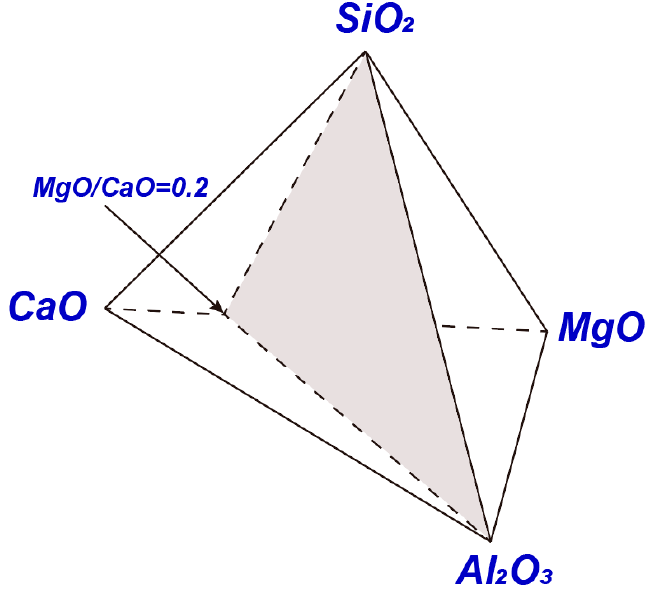
Figure 16. Representation of the pseudo-ternary phase diagrams (CaO + MgO)-Al 2 O 3 + SiO 2 at a constant MgO/CaO ratio of 0.2 [23]. An experimentally determined pseudo-ternary phase diagram (CaO + MgO)-Al 2 O 3 - SiO 2 with a constant MgO/CaO ratio of 0.2 is shown in Figure 17. A typical BF slag com- position and four special points are also shown in the figure. When the compositions of the iron ores and coke/coal vary, the Al 2 O 3 and SiO 2 contents in the BF slag will change accordingly. Based on Figure 17, the effects of Al 2 O 3 concentration, ternary and quater- nary basicity and Al 2 O 3 /SiO 2 on the liquidus temperature of the BF slags were discussed from different directions. Figure 18 shows the liquidus temperatures of the BF slag as a function of (CaO + MgO)/SiO 2 at content 10, 15 and 20 wt% Al 2 O 3 . Melilite and Ca 2 SiO 4 are the main prima- ry phases present around the typical BF slag. When high-grade feeds are available, the